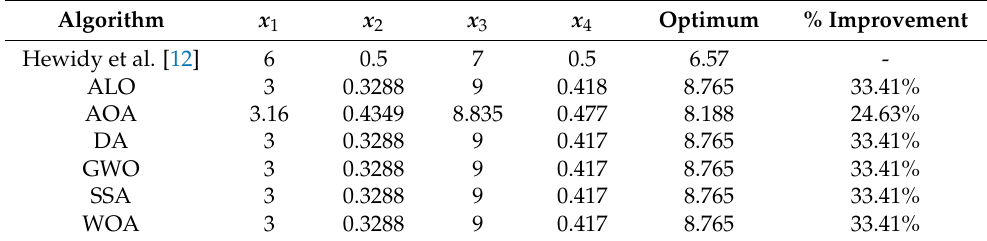
Table 2. Comparison of current results with solutions from the literature for MRR optimization.